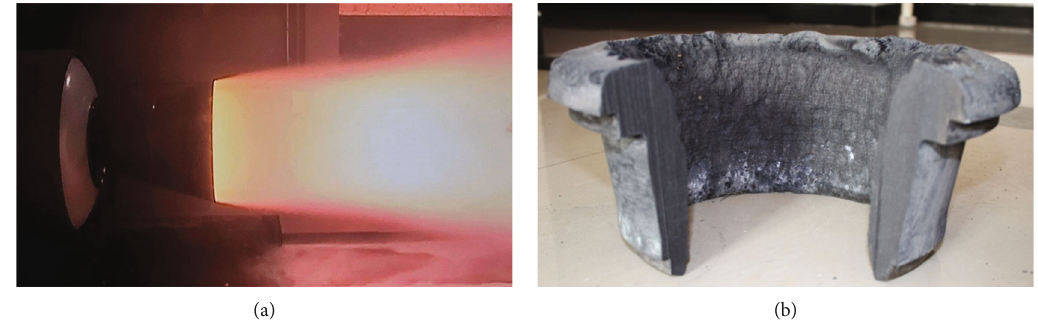
Figure 9: Solid rocket motor ground test: (a) the nozzle fl ow fi eld and (b) C/C throat insert cross section after the SRM test.